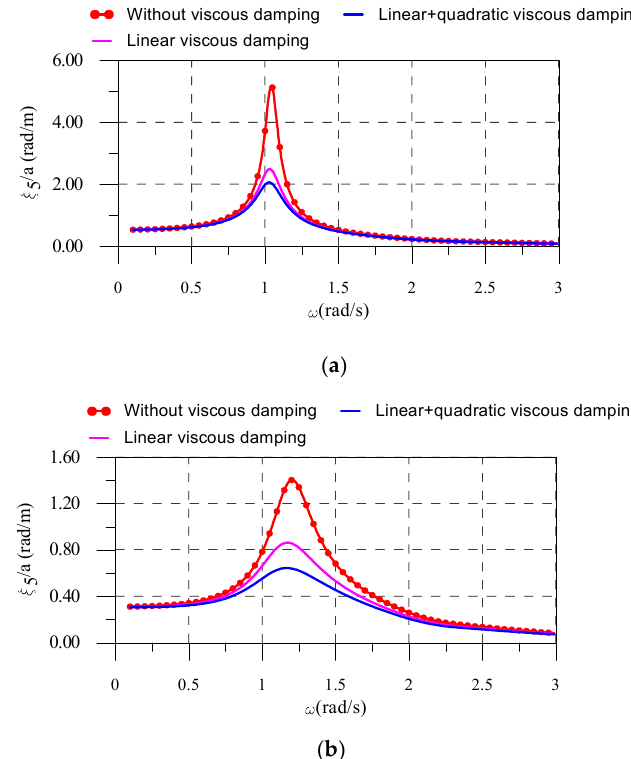
Figure 9. ( a ) Rotor I ( b ) Rotor II; variation of the pitch response of the different rotors as a function of